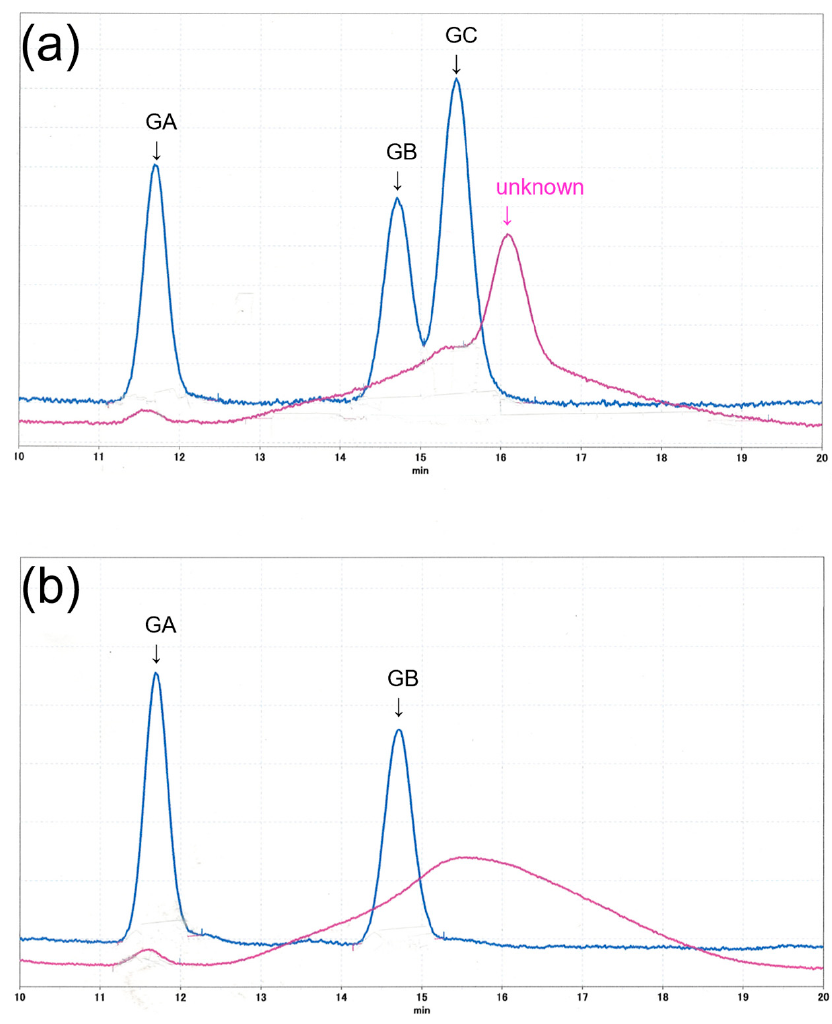
Figure 6. HPLC profiles of ethyl acetate fractions of female extracts of A. glabripennis (red lines, 2 fe) and A. malasiaca (blue lines, 0.2 fe). ( a ) detected by UV 210 nm, and ( b ) 254 nm. GA: gomadalactone A; GB: gomadalactone B; GC: gomadalactone C.